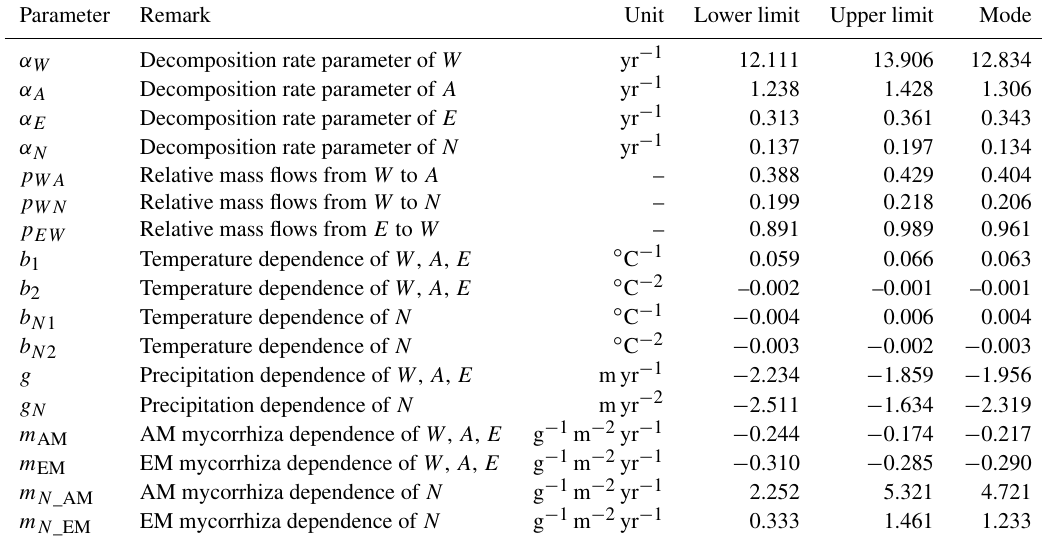
Table C1. Posterior and 95% Bayesian credibility intervals (confidence limits) for the Yasso_Myco parameters.